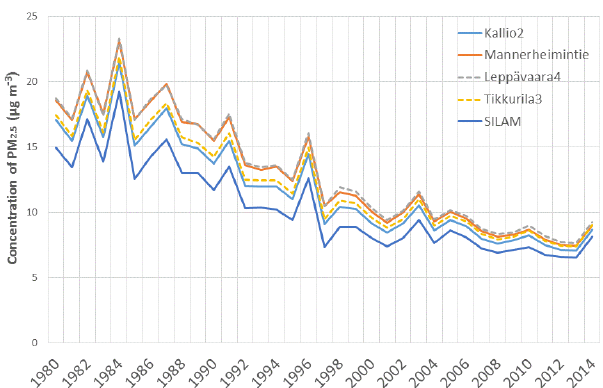
Figure 7. The predicted annual average concentrations of PM 2 . 5 at four stations in the Helsinki Metropolitan Area from 1980 to 2014, and the predicted regional background concentrations